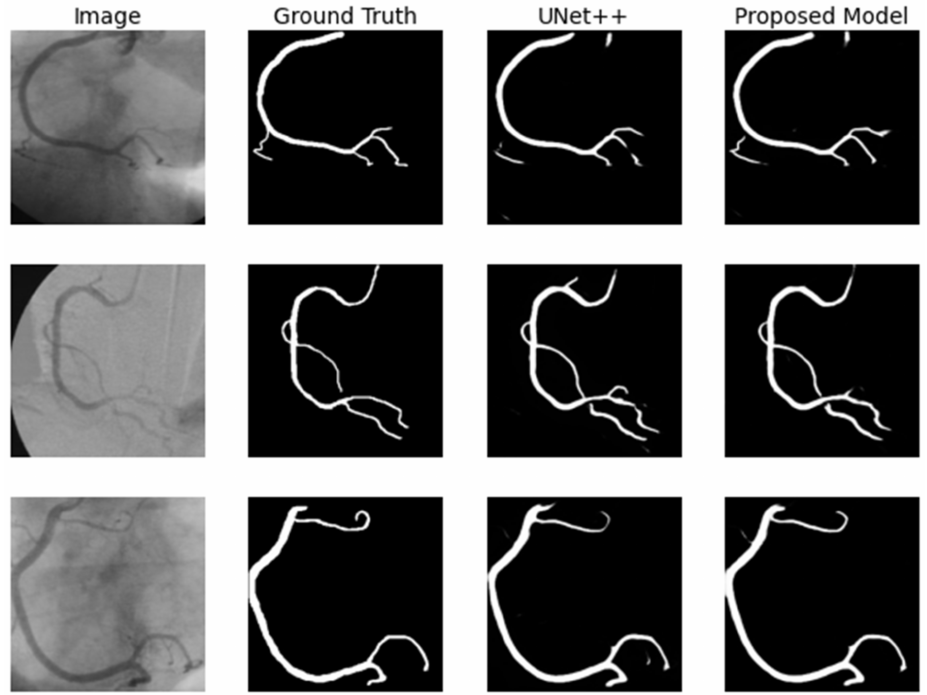
Figure 15. Qualitative assessment of the performance of UNet++ and Residual-Attention UNet++ on coronary artery in angiography.